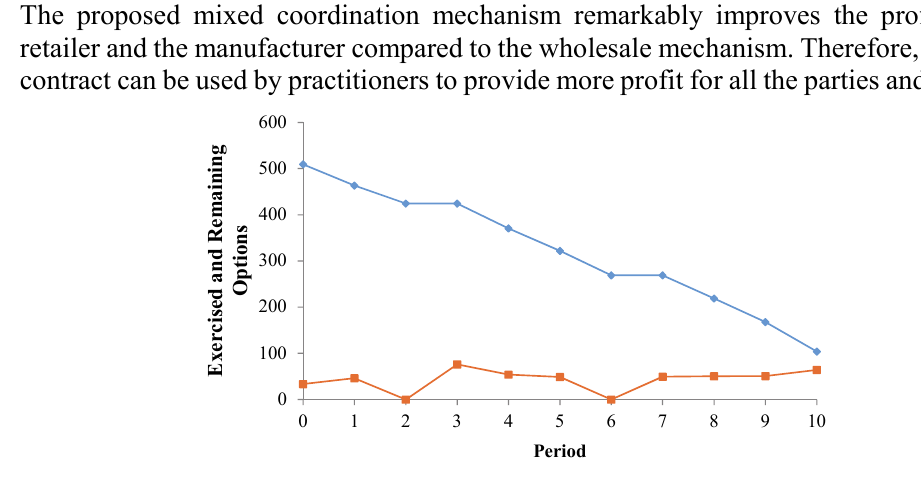
Centralized Non-cooperative Wholesale (Cooperative) Decentralized